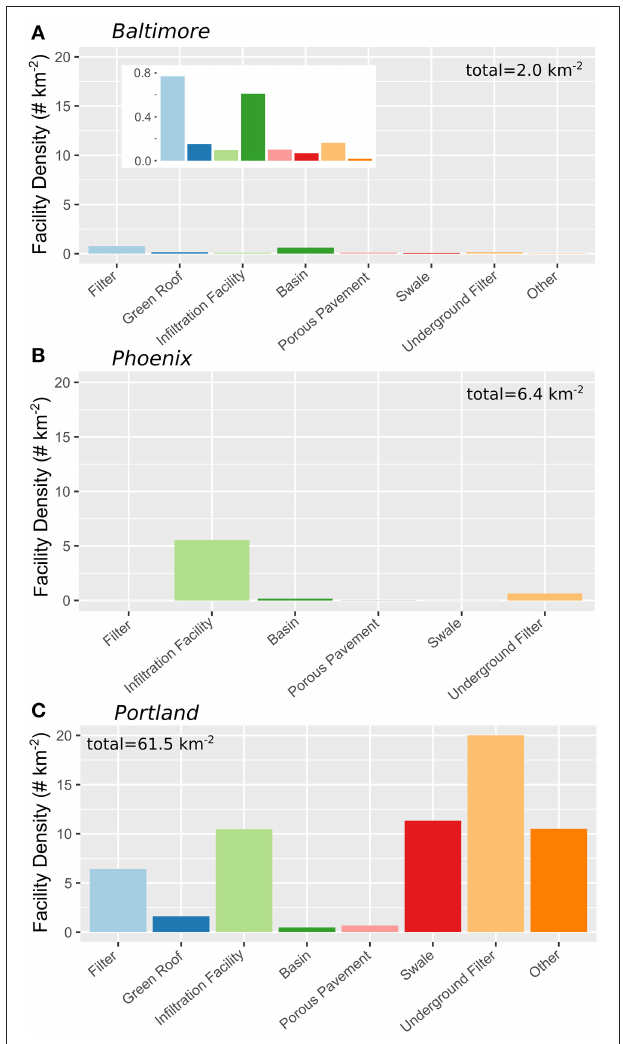
FIGURE 8 | Density of various SCM types based on most recent data (2017), normalized by city area, in (A) Baltimore, (B) Phoenix, and (C) Portland. Total density of all SCMs for each city is indicated. Colors indicate similar types of SCMs. An inset graph in (A) has a re-scaled y-axis to better show the relative differences between SCM types in